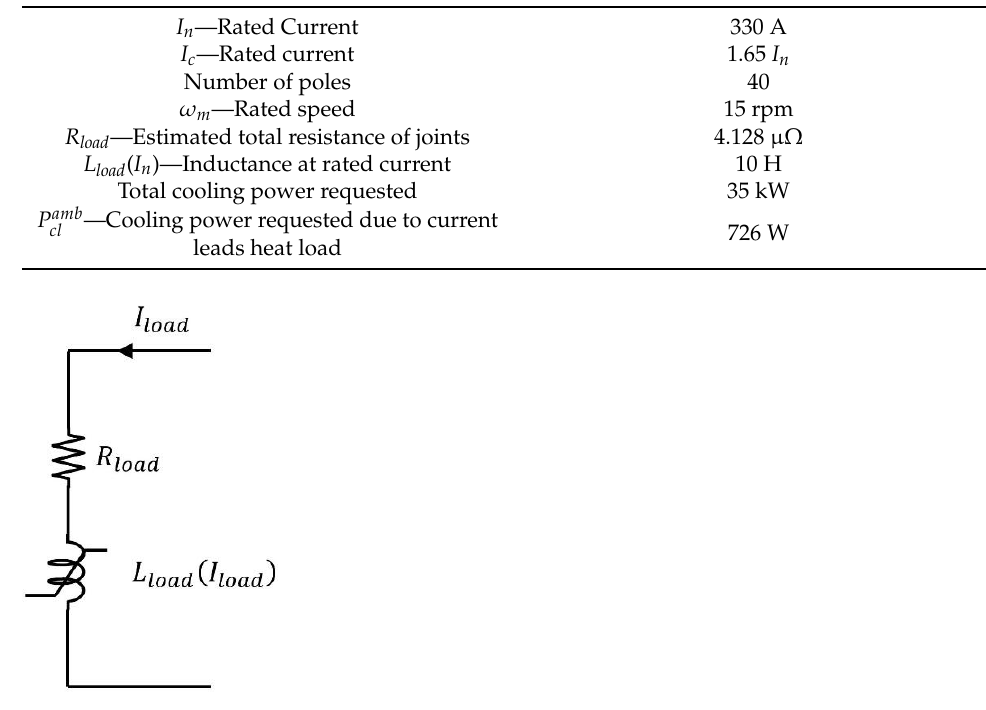
Table 1. HTS field winding specifications.